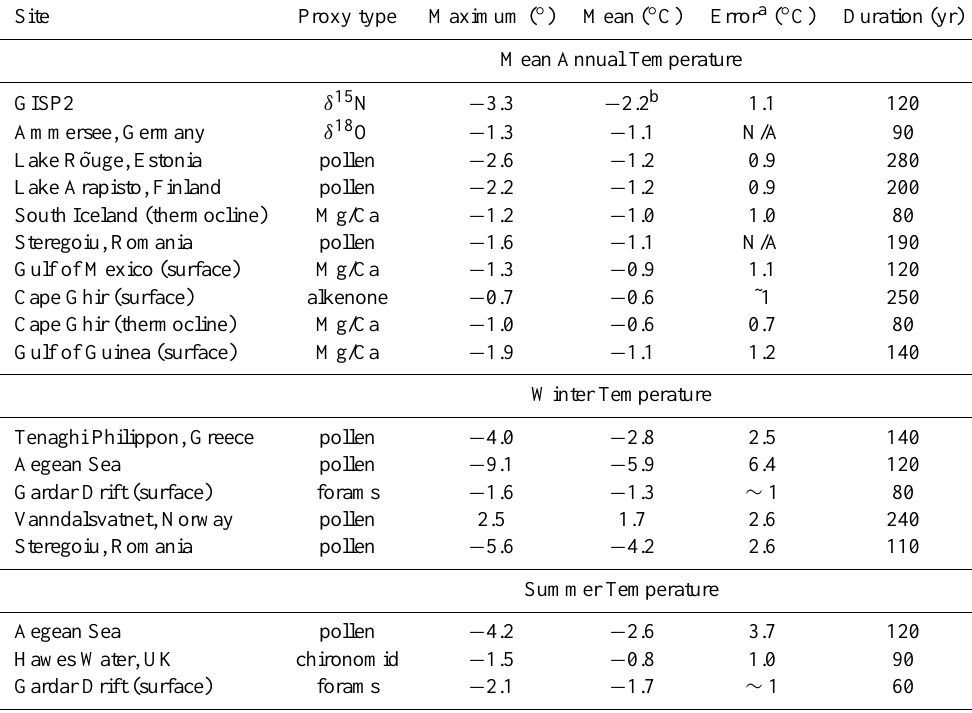
Table 1. Quantitative temperature anomalies from early Holocene background values.